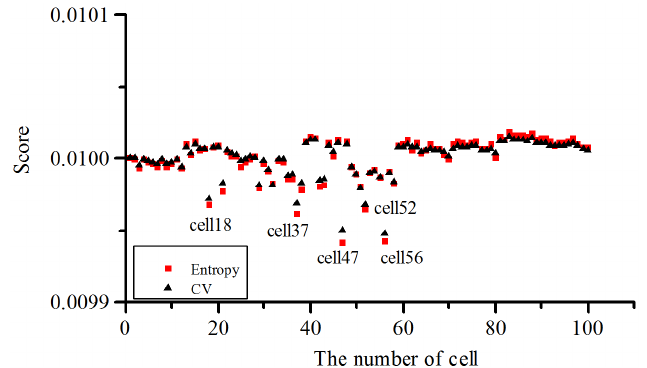
Figure 11. Comparison curve of CV and entropy method of Vehicle 1 during period 2.